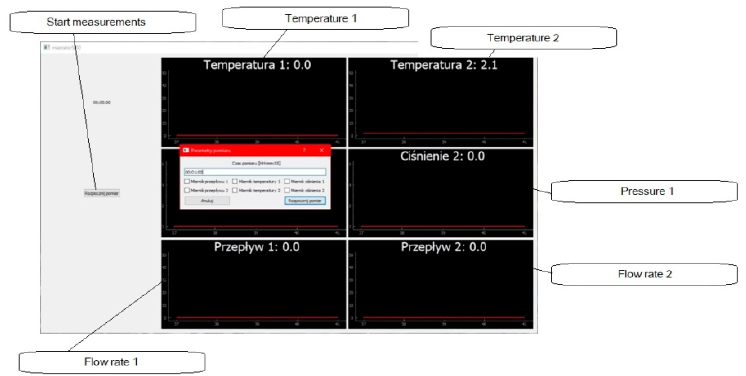
Figure 7. The main window of the measurement application with the “Measurement parameters” window (in Polish).